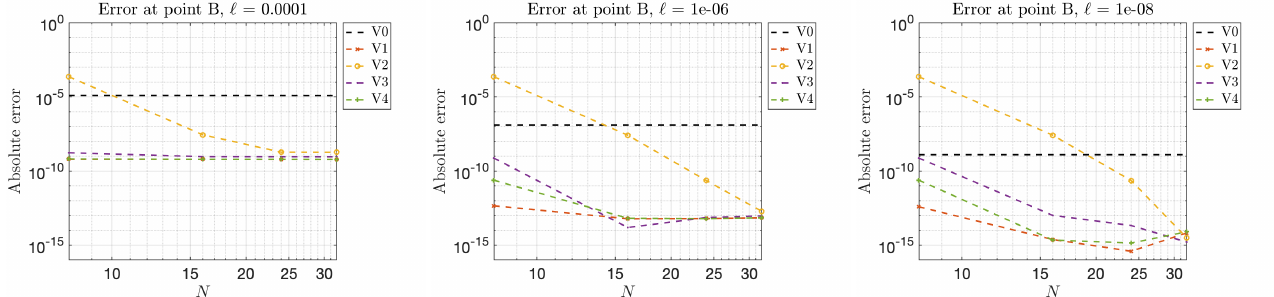
Figure 4. Laplace 3D single-layer. Log-log plots of the errors with respect to (cid:96) made in comput- ing the solution of (2) for the Neumann data, g ( x ∗ ) = − n x ∗ of a sphere a radius 2, along the normal of point A = ( − 0.0065, − 0.0327,1.9997 ) ( left ), of point B = ( − 0.3526, − 1.7728,0.8561 ) ( right ).